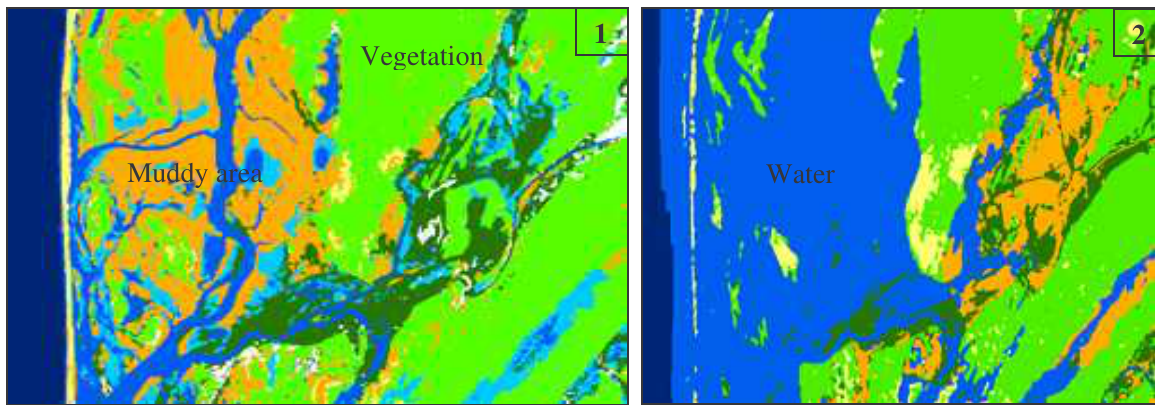
Figure 6: The classification results (1. Normal situation in 2001, 2. Flood situation in